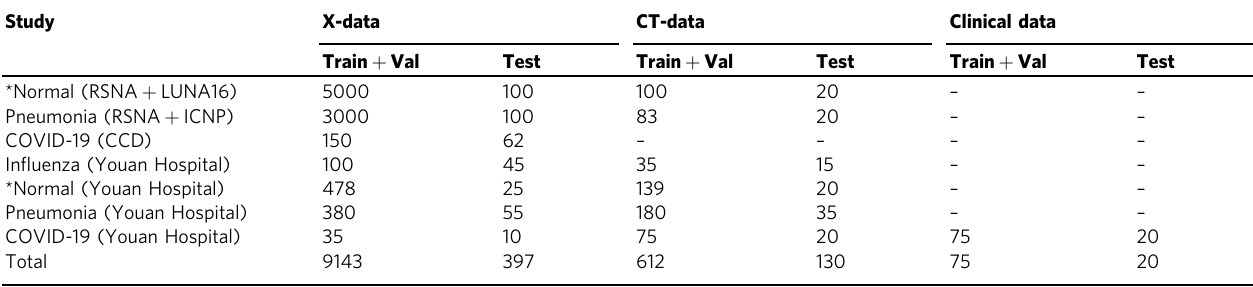
Table 1 Number of cases from four public data sets and the Youan hospital (X-data, CT-data, clinical indicator data).